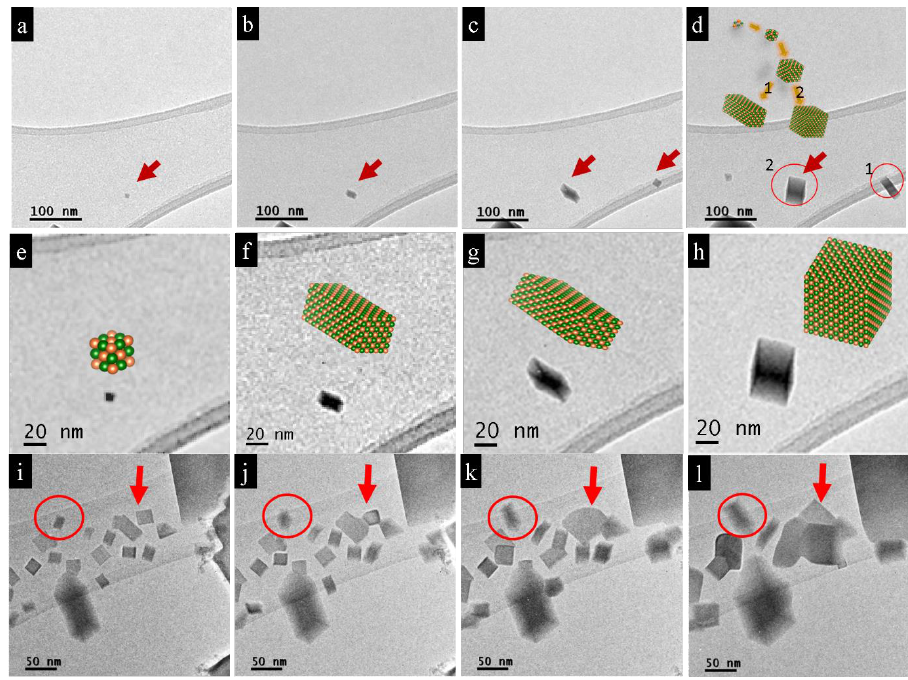
Figure 6. Formation of PbTe nano-cubes and nano-bars during the electron-beam treatment. ( a – d ). Overview of images of a single nano-bar nucleation on the carbon substrate during the melting of the initial µm-sized particles. ( a ) Initial and ( b – d ) subsequent gradual growth of nucleated PbTe nano-bars. ( e – h ) Magnified micrographs and snapshots of the growth process of the pitched-on particle marked with a red arrow in (a). ( e ) The starting size is about 8 nm when the particle could be clearly imaged and ( h ) about 40 nm in the final state of the observation period. The particle undergoes different aspect ratios being, e.g., brick-like ( g ) to a subsequent cube-like ( h ) form. ( i – l ) Growth of an assembly of nano-bars, one dominant rod marked by a red arrow grows incorporating fast vicinal particles. Nano-bar marked with a red circle develops freely without interfering with other nanoparticles.